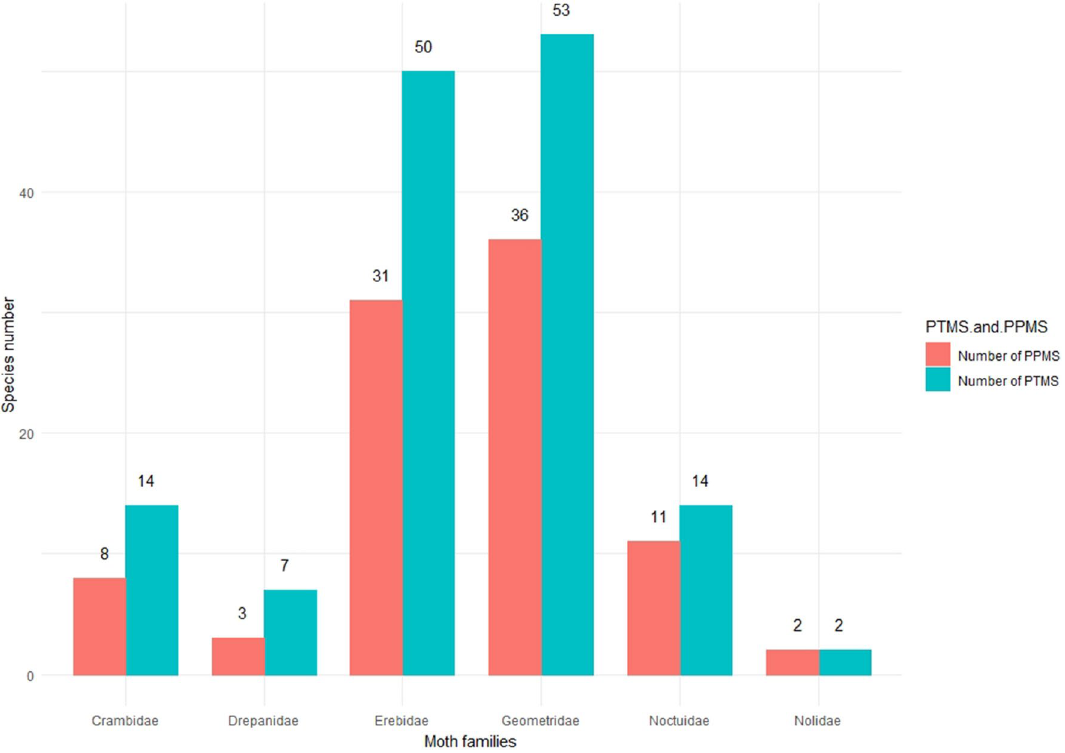
Figure 2. Family-wise species composition of PTMS and